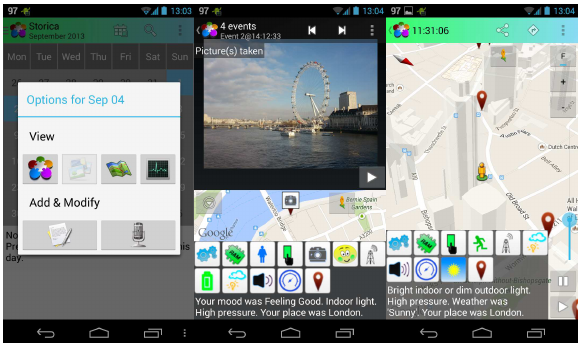
Figure 6 . Visualisations in Storica: Calendar-based entry (a), story-based view (b) and map-based view with fly-over effects